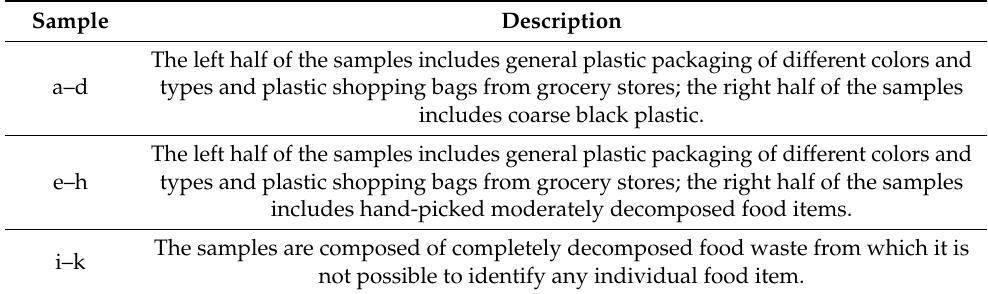
Table 1. Description of all samples used in test case 1.